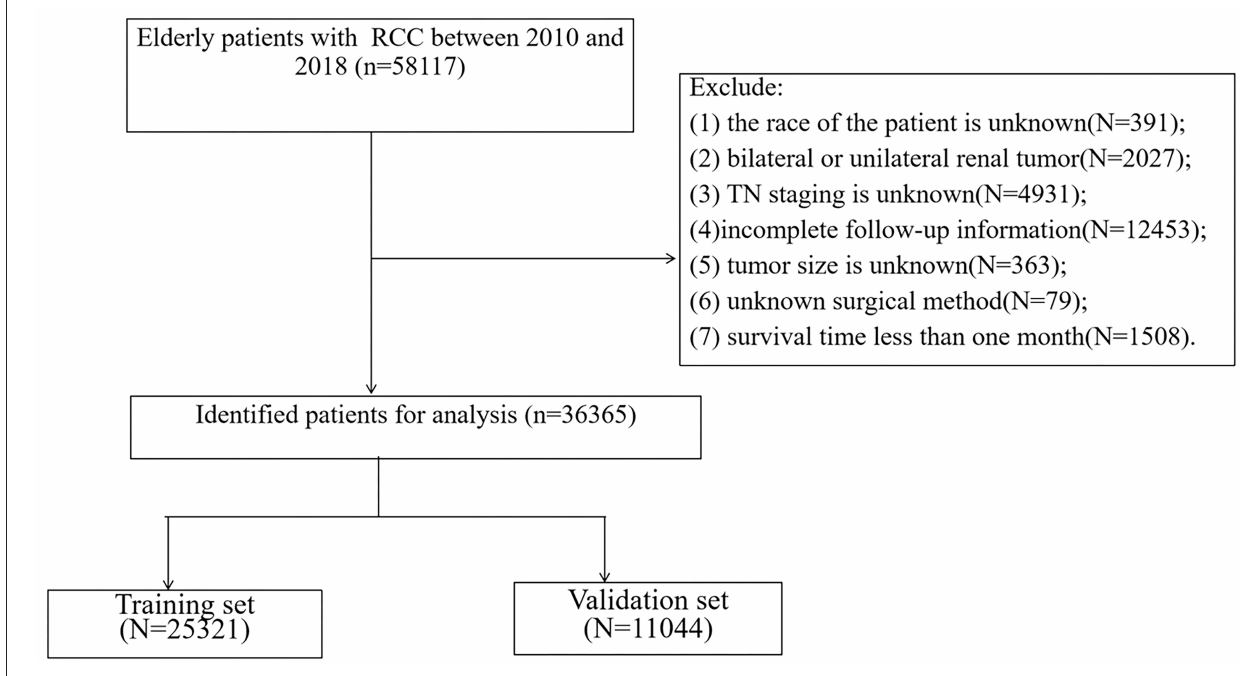
FIGURE 1 | The flowchart of including and dividing